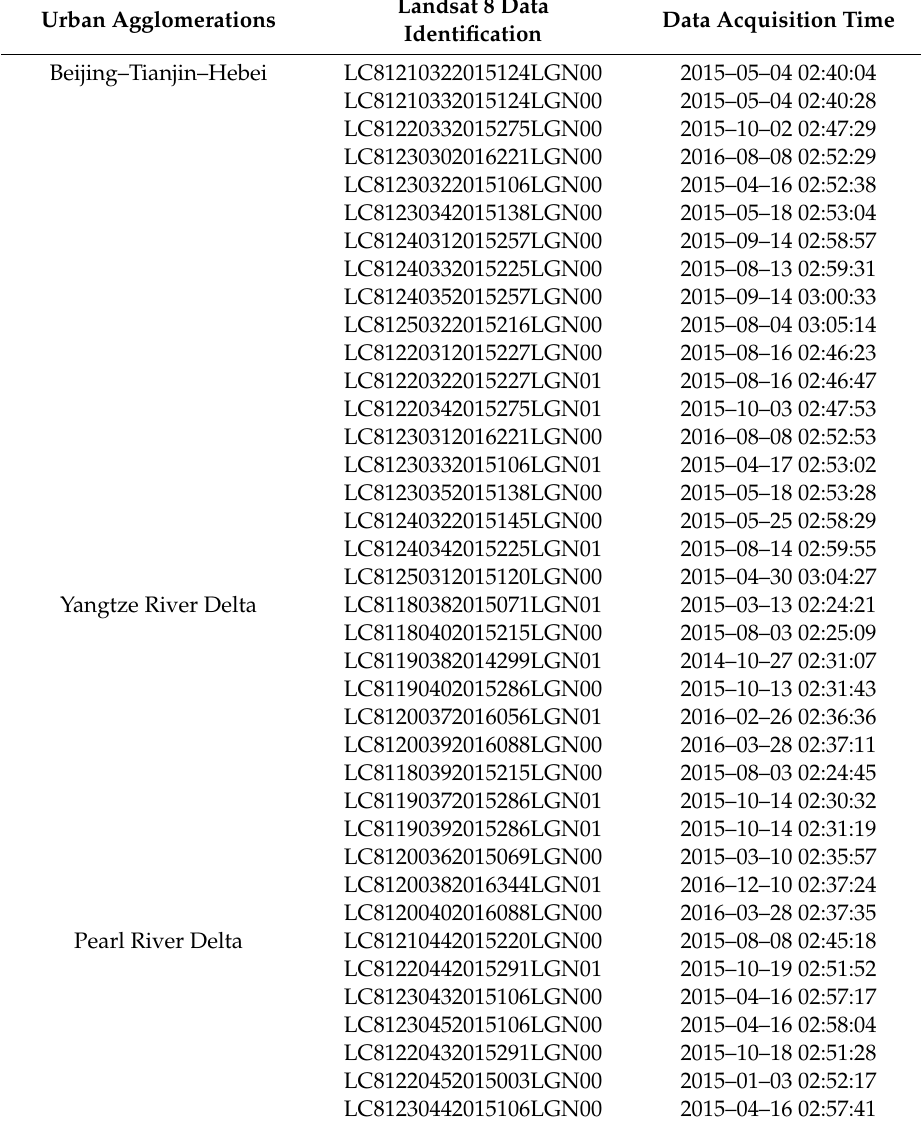
Table 1. Landsat 8 OLI / TIRS imagery information of the study